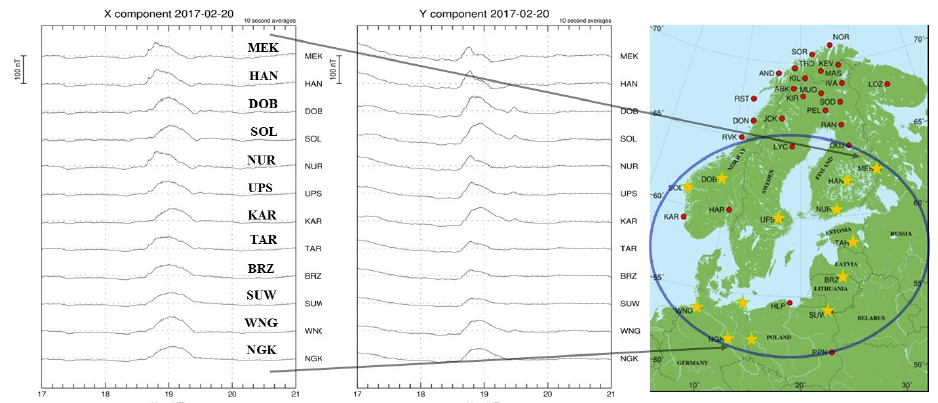
Fig.3. Two panels to the left: X and Y components of the magnetic field by all IMAGE stations where positive bays were observed. Right panel: locations of the IMAGE satations with positive X-bays, marked by